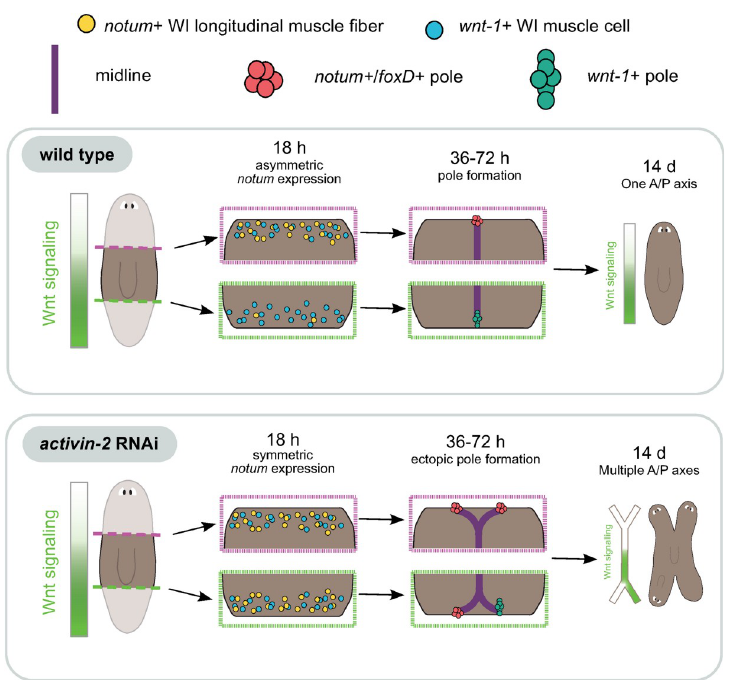
Fig 7. activin-2 RNAi animals display a regeneration-specific polarity defect in patterning correlated with a loss of wound-induced notum polarity. Model of regeneration with activin-2 RNAi defects depicted. Animals possess a wnt expression gradient from posterior to anterior. Upon amputation in activin-2 RNAi animals, notum wound- induced gene expression (6–24 hr) is no longer spatially restricted to the anterior. Multiple midlines and poles can form, including anterior poles at the posterior-facing wound (36-72 hpa). Posterior identity is maintained in regenerated animals, with ectopic anterior axes (14 d).